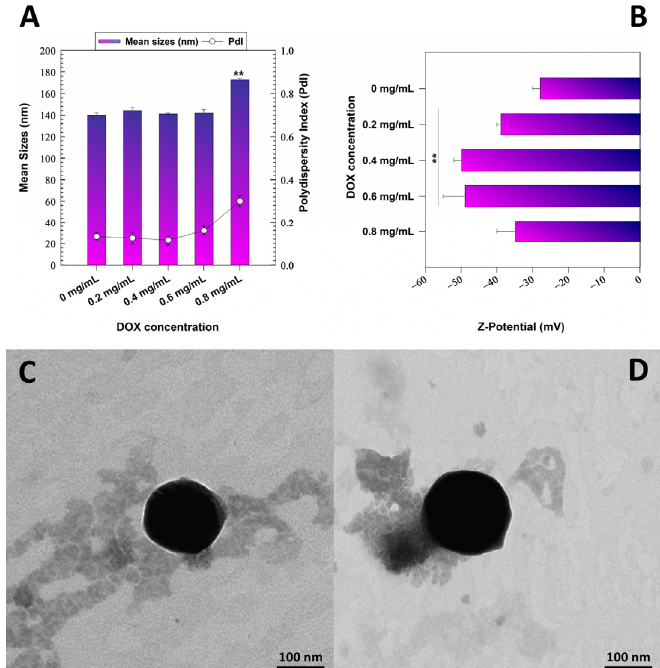
Figure 1. ( A ) Mean sizes, polydispersity index and ( B ) surface charge of GNPs (1 mg/mL of protein, 0.1% w/v of polyoxyethylene (2) oleyl ether) prepared with various amounts of DOX (0.2–0.8 mg/mL). Results are expressed as the mean of three independent measurements performed in triplicate on three different samples ± standard deviation. ** p < 0.001 with respect to the empty formulation. TEM images of ( C ) empty and ( D ) GNPs prepared with 0.6 mg/mL of drug.